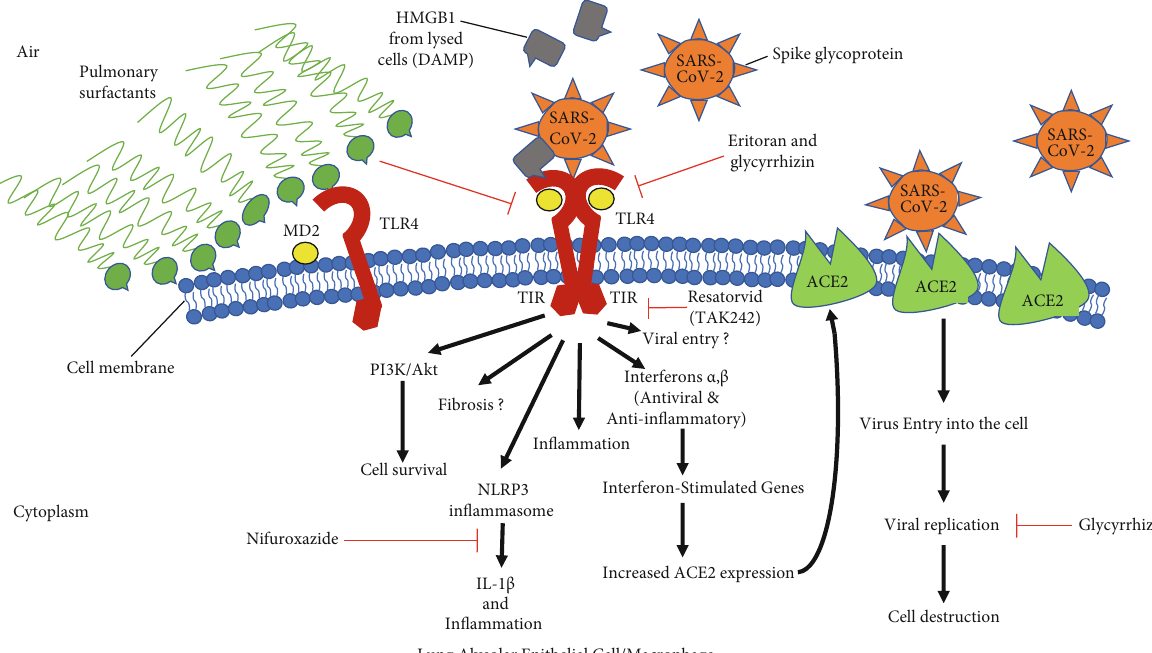
Figure 1: Graphical abstract. Note that less pulmonary surfactant secretion leads to exposed TLR4 receptors on alveolar cells. HMGB1 released from lysed cells can also activate TLR4 causing excessive in fl ammation and fi brosis. The same model applies to a cardiac cell, except that there would be no pulmonary surfactants, and instead of the outside air, it would be the extracellular matrix. In the heart, TLR4 activation by the SARS-CoV-2 virus and/or DAMPs released from infected, necrotic cells or even upregulated at sites of injury may also cause abnormal signalling towards the canonical proin fl ammatory pathway rather than the alternative anti-in fl ammatory pathway. This would cause viral myocarditis. TLR4 activation also decreases the contractility of cardiomyocytes. In addition, SARS-CoV-2 may activate TLR4 to increase PI3K/Akt signalling in infected cells, preventing apoptosis and thus increasing time for viral replication. Aberrant in fl ammatory signalling could also be extended to other tissues expressing TLR4, such as the skin and kidney, where the virus would therefore cause multiple-organ